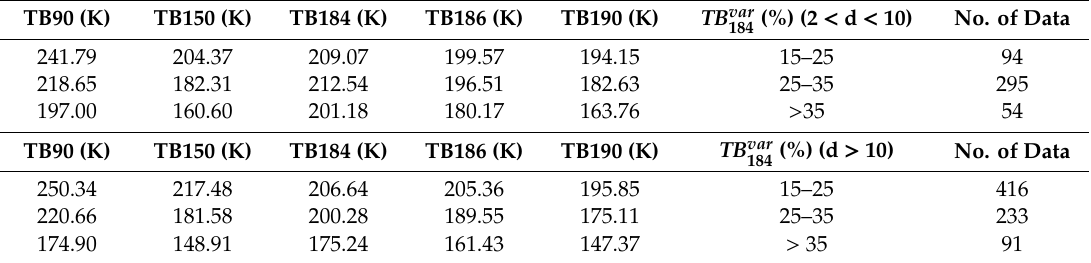
for di ff erent hail diameters 184